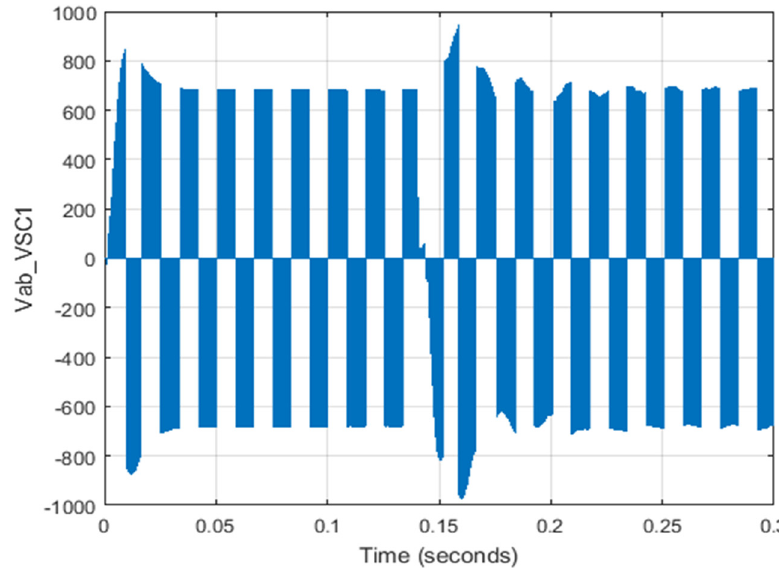
Figure 23. Two-phase voltage ab for VSC-1.